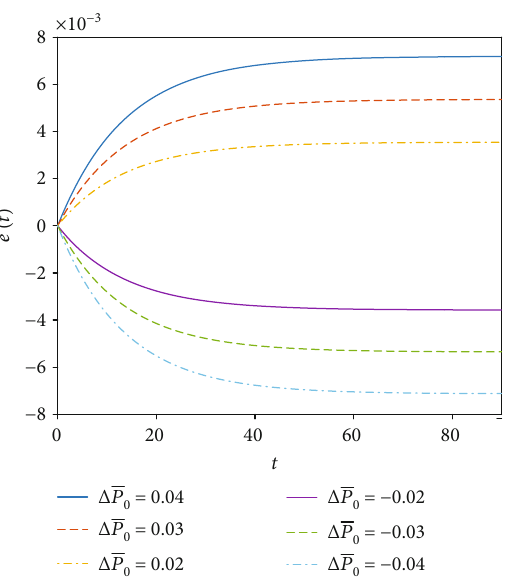
Figure 5: Viscoelastic-creep behaviors, e ð t Þ , under di ff erent values (cid:1) j = 0 : 2600 , ϵ = 0 : 2000 , of constant pressure, Δ , at conditions j (cid:1) ρ P 0 0 and L = 1 where t ( x -axis) is the time variable and e ð t Þ ( y -axis) def is the strain response at time t . The results show the capability of (cid:1) the PCD equation to control e ∞ through Δ P 0